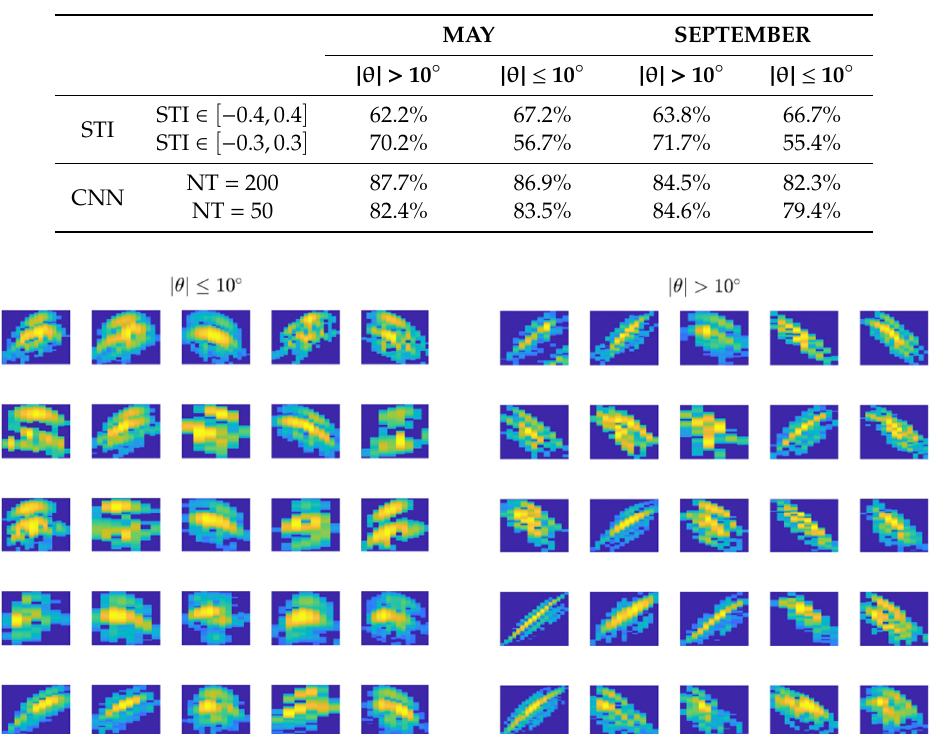
Table 2. True positives of tilted ( | θ | > 10 ◦ ) and non-tilted ( | θ | ≤ 10 ◦ ) samples using Swimming Tilt Indicator (STI) and a Convolutional Neural Network (CNN) grouped by months. NT: Number of tilted and non-tilted images used for network training.